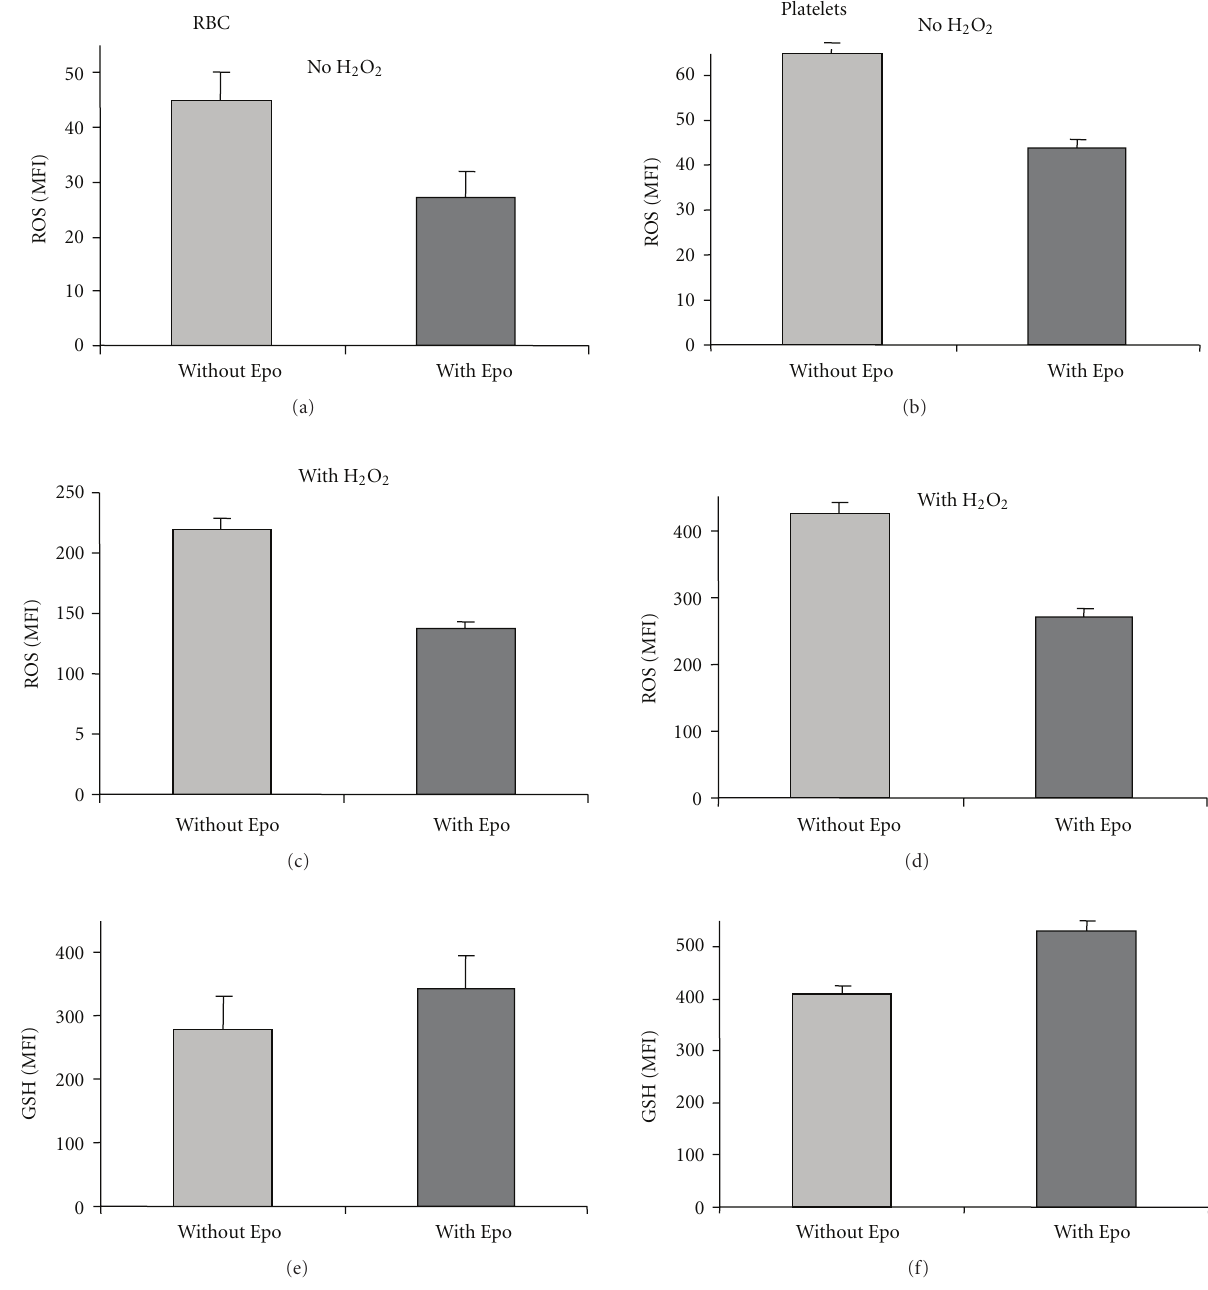
Figure 3: E ff ect of Epo on the oxidative stress of RBC and platelets from thalassemic patients. Diluted blood samples were untreated with or without 1 U/ml Epo for 3 hrs at 37 ◦ C, then stimulated (a, b) or not (c, d) with 1mM H 2 O 2 for 15min, and assayed for ROS. RBC (e) and platelets (f) treated with or without Epo were also assayed for GSH. The results, presented as the average ( N = 11) of the mean fluorescence index (MFI) ± SD, show a decrease in ROS ( P < . 05) and an increase in GSH ( P < . 05) following Epo